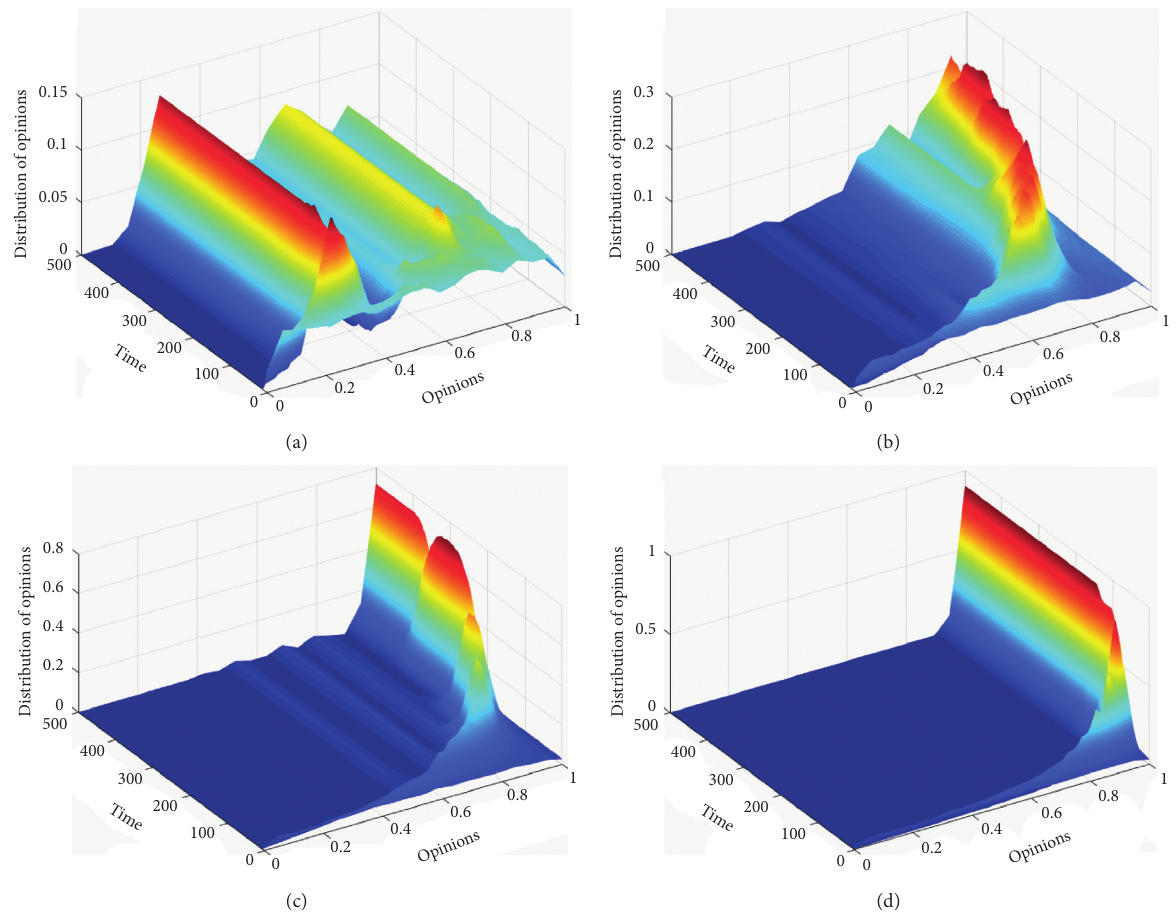
Figure 2: Group opinion distribution evolution when x � 1/2. With the increase of d close to 1 is increasing. (a) d m � 0 . 25. (b) d m � 0 . 5. (c) d m � 0 . 65. (d) d m � 0 .